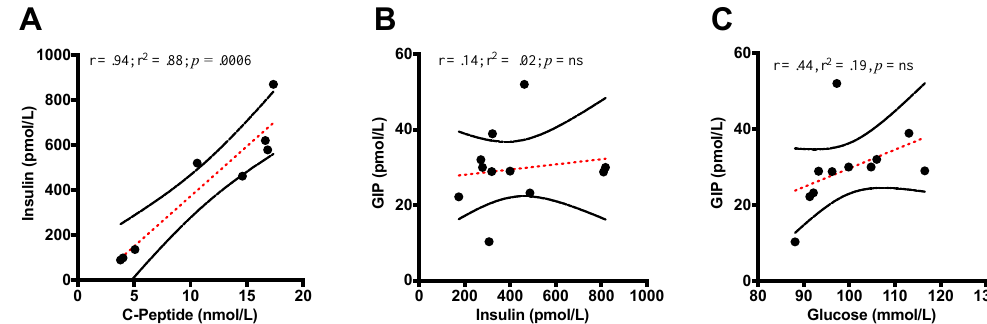
(Figure 8B: r = 0.14; r 2 = 0.02; p = ns). A correlation was found between insulin and C-peptide (Figure 8A: r = 0.94, r 2 = 0.88, p = 0.0006). (Figure 8A: r = 0.94, r 2 = 0.88, p = 0.0006). 8A: r = 0.94, r 2 = 0.88, p = 0.0006).